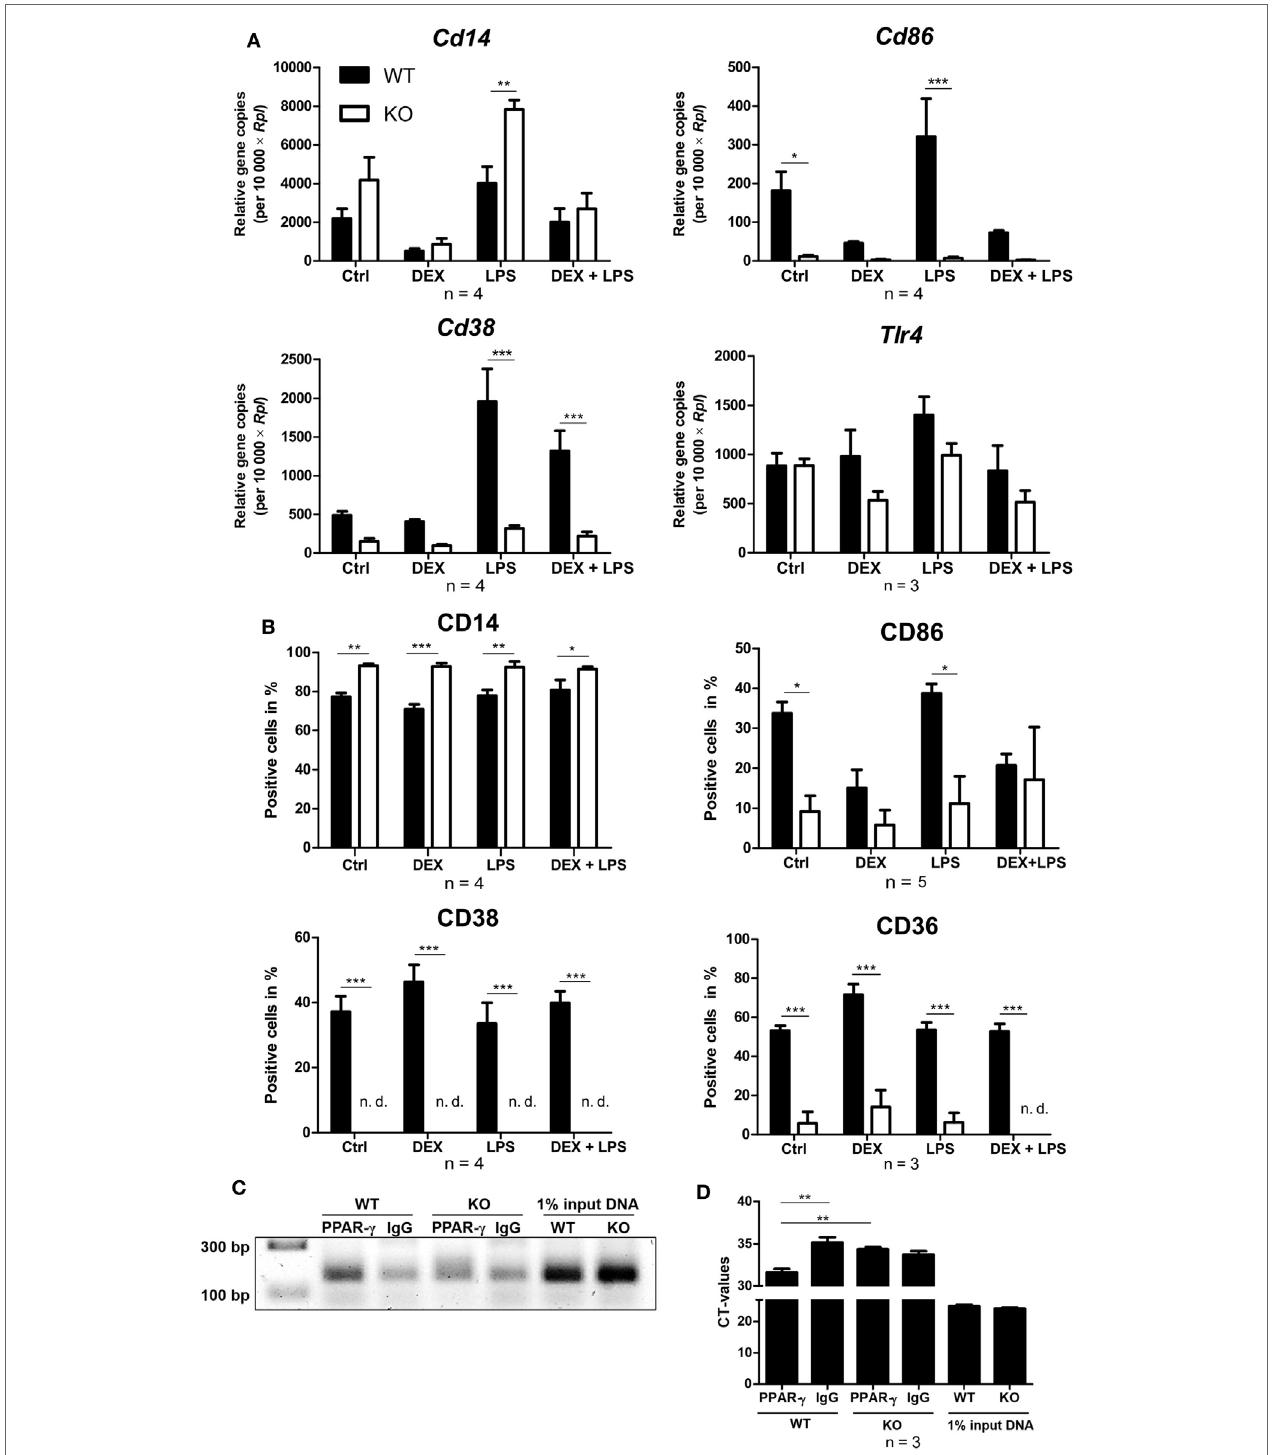
FigUre 5 | Altered expression of cell surface proteins on peroxisome proliferator-activated receptor (PPAR)- γ -deficient macrophages. (a,B) On day 5 of differentiation, ER-Hoxb8 cells were stimulated with dexamethasone (DEX) (100 nM) and/or LPS (1 µg/ml) for 24 (a) or 48 h (B) . (a) Gene expression of the indicated genes was analyzed using qPCR. (B) Surface expression of the indicated proteins was investigated by FACS. (c,D) On day 2 of differentiation, ER-Hoxb8 cells were subjected to chromatin immunoprecipitation to detect binding of PPAR- γ to putative PPAR response element located within intron 1 of murine CD38 gene. (c) Figure shows result from one representative experiment out of three performed. (a,B,D) The bars represent the mean with the SEM of three to five independent experiments (* p < 0.05, ** p < 0.01, *** p < 0.001) (calculated by using two-way